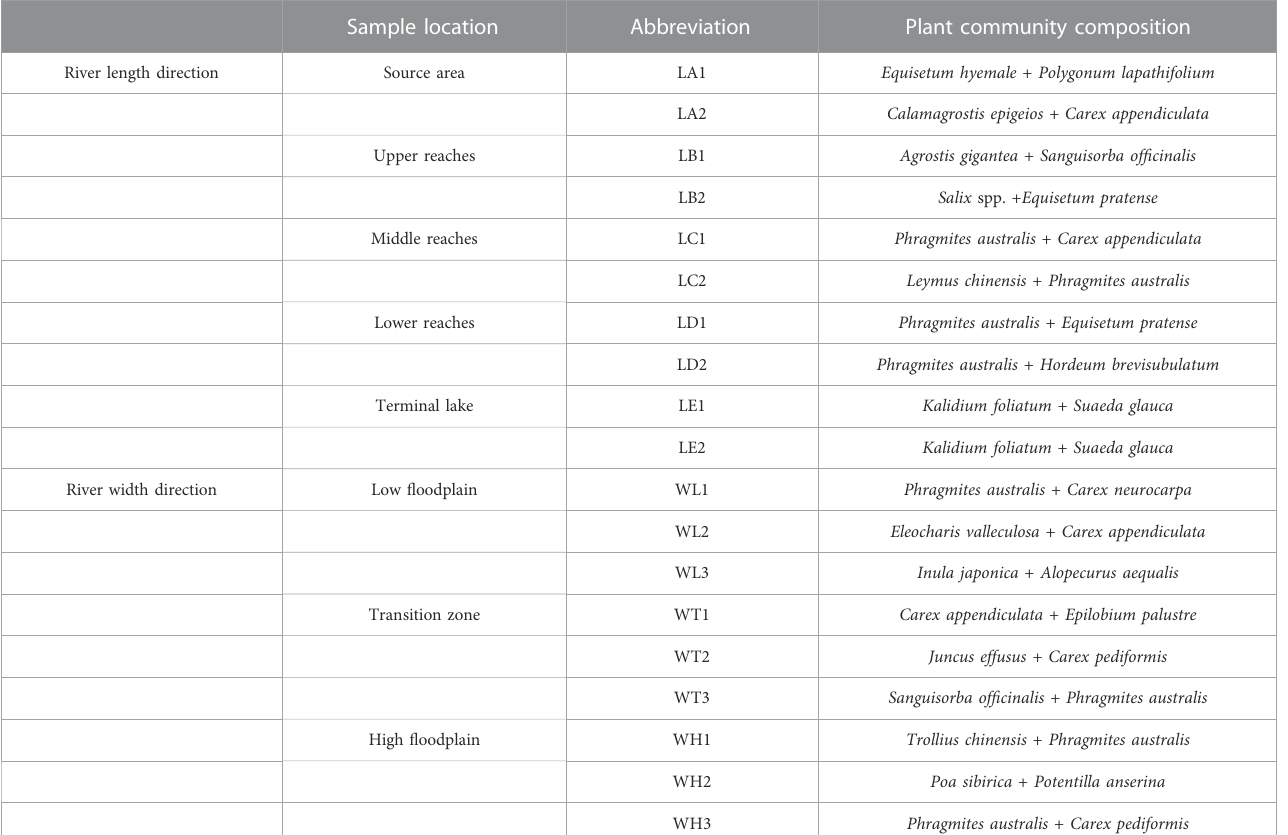
TABLE 1 Basic information of the plant community in the sample sites.